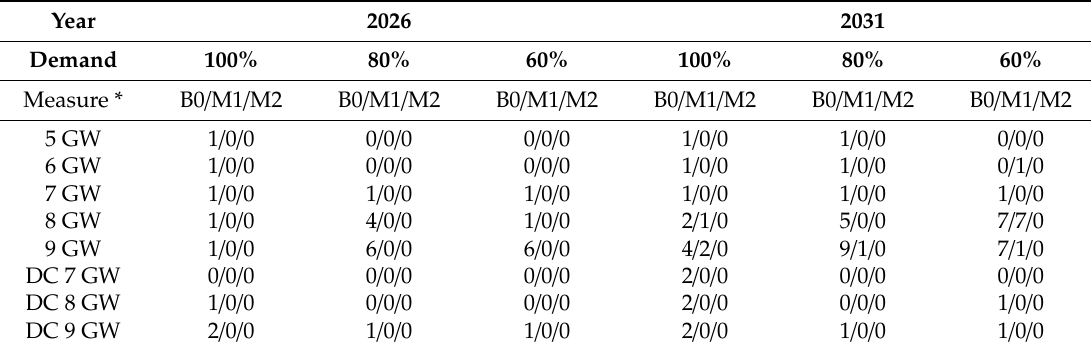
Table 16. The number of overloads in 2026 and 2031 after